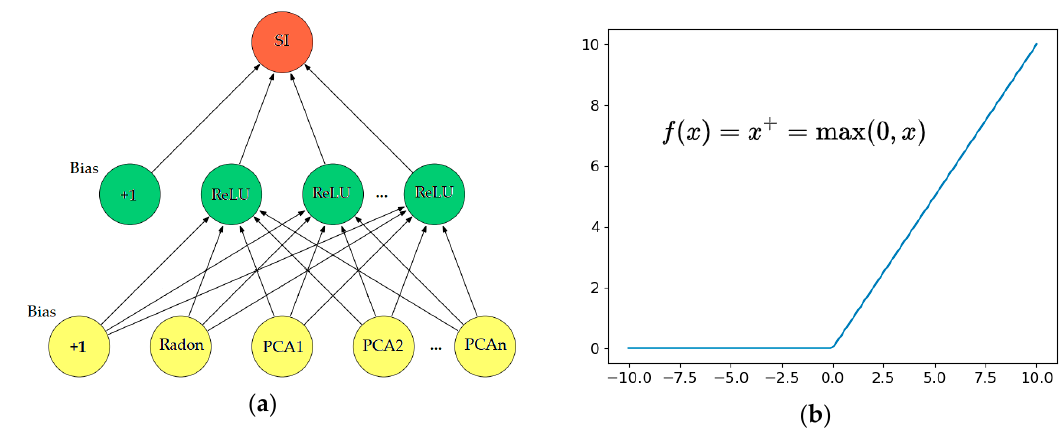
Figure A1. Statistics for different ANN models where several hyperparameters are changed (number of hidden layers and number of neurons per hidden layer). ( a ) R2 score training test ratio ( b ) MSE on a test set. All models have radon and 2 particulate matter related PCA components as inputs. Figure C1b uses log10 scale.